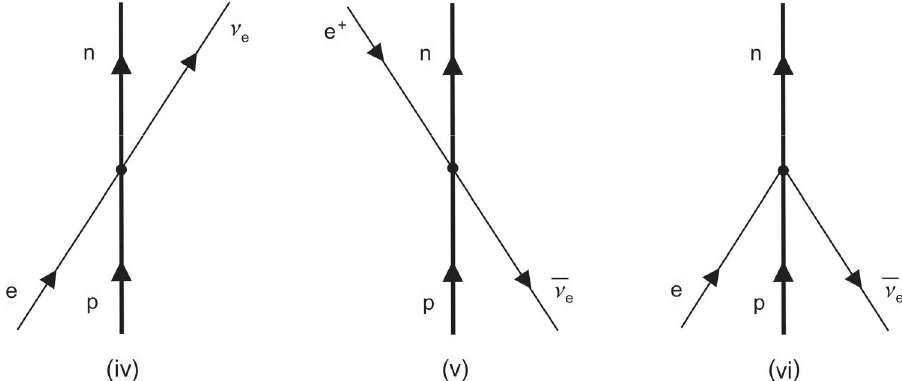
Fig. 3 Inverse β -decay in the comoving frame in the absence of flavor oscillations (time flows in the vertical direction). The three processes are allowed due to the absorption (emission) of particles from (to) the Unruh thermal